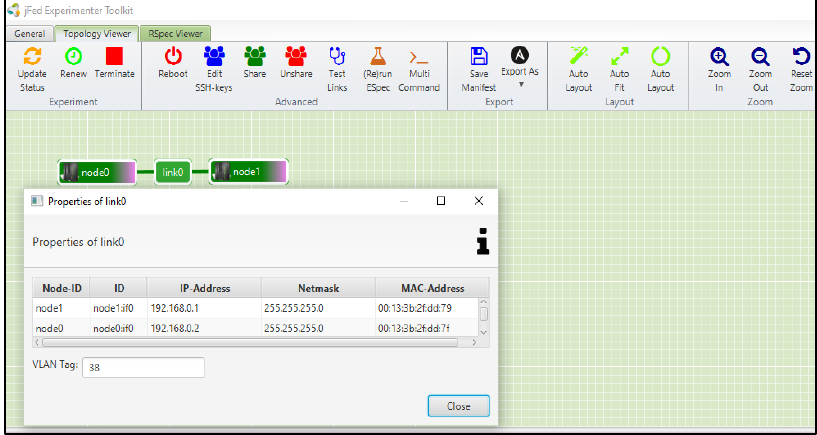
Figure 11. Interconnection between Node0 and Node1.